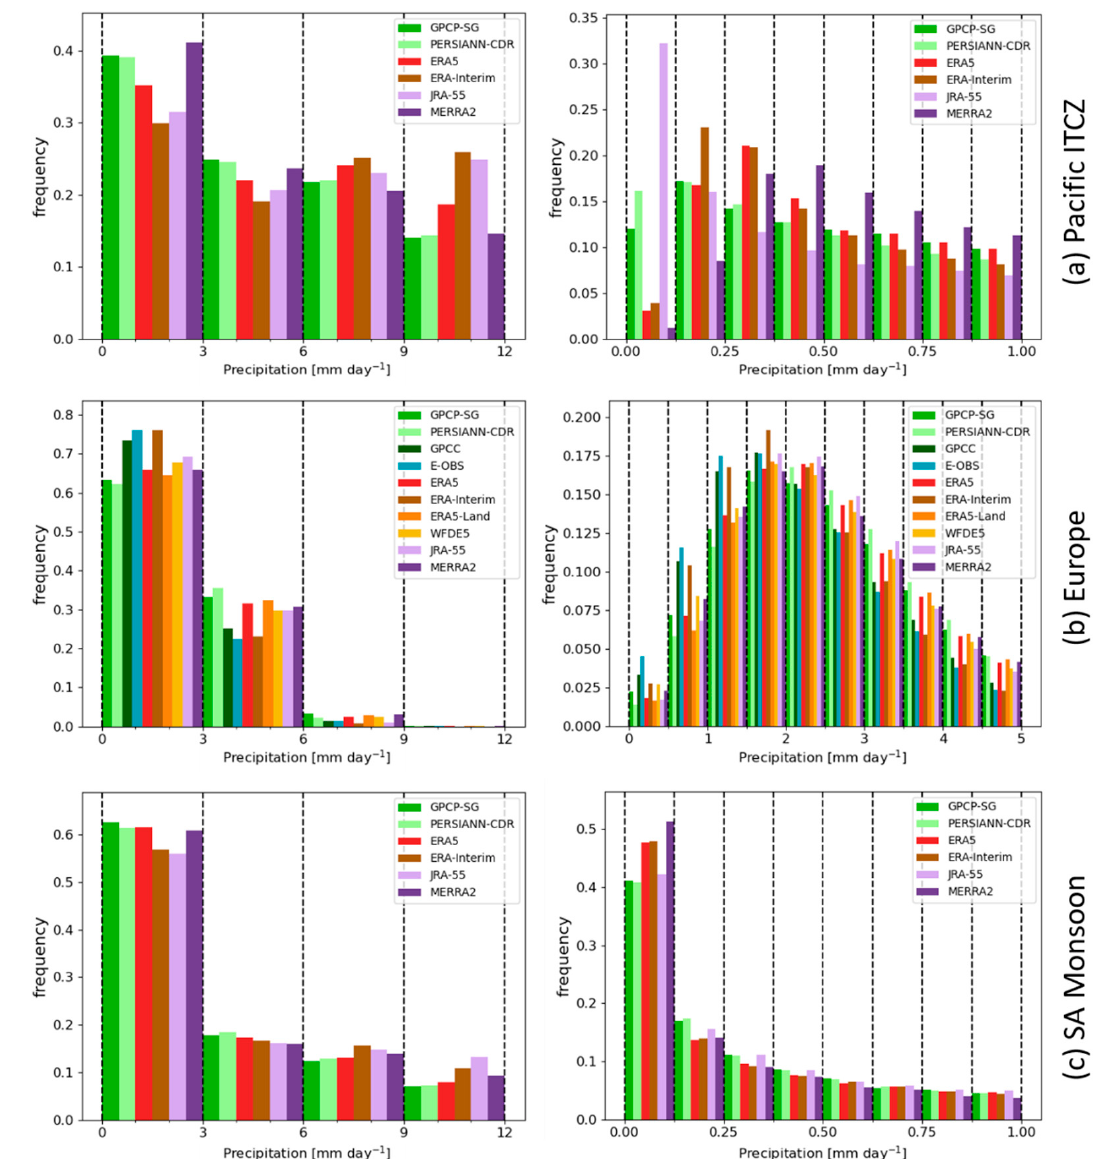
Figure 5. Histograms of the precipitation rate values in ( a ) the Pacific ITCZ (0 ◦ –12 ◦ N, 136 ◦ E–85 ◦ W), ( b ) Central Europe (42 ◦ N–53 ◦ N, 0 ◦ –20 ◦ E), and ( c ) the SA Monsoon region (5 ◦ N–30 ◦ N, 65 ◦ E–95 ◦ E) with no values masked, for the 0–12 mm day − 1 range (left column) and 0–1 mm day − 1 range for the Pacific ITCZ and SA Monsoon regions and 0–5 mm day − 1 for Europe (right column). Histograms were calculated using monthly mean values in the period 1983–2016. ERA5-Land, GPCC, and WFDE5 are only shown in the histograms for regions without ocean grid cells.